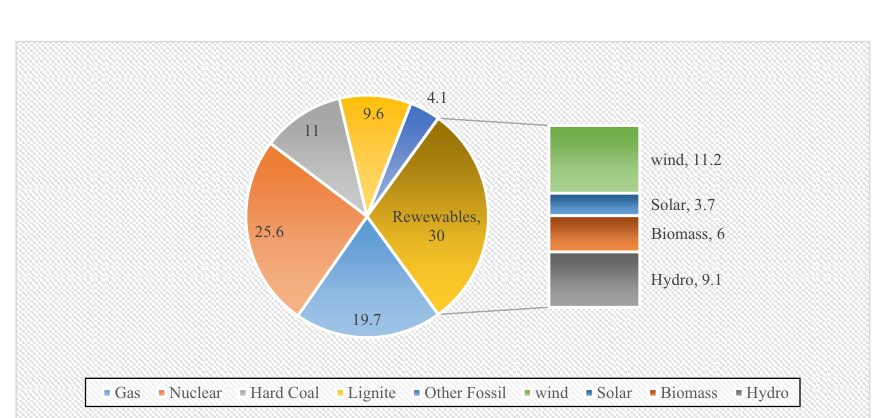
Figure 7. European electricity